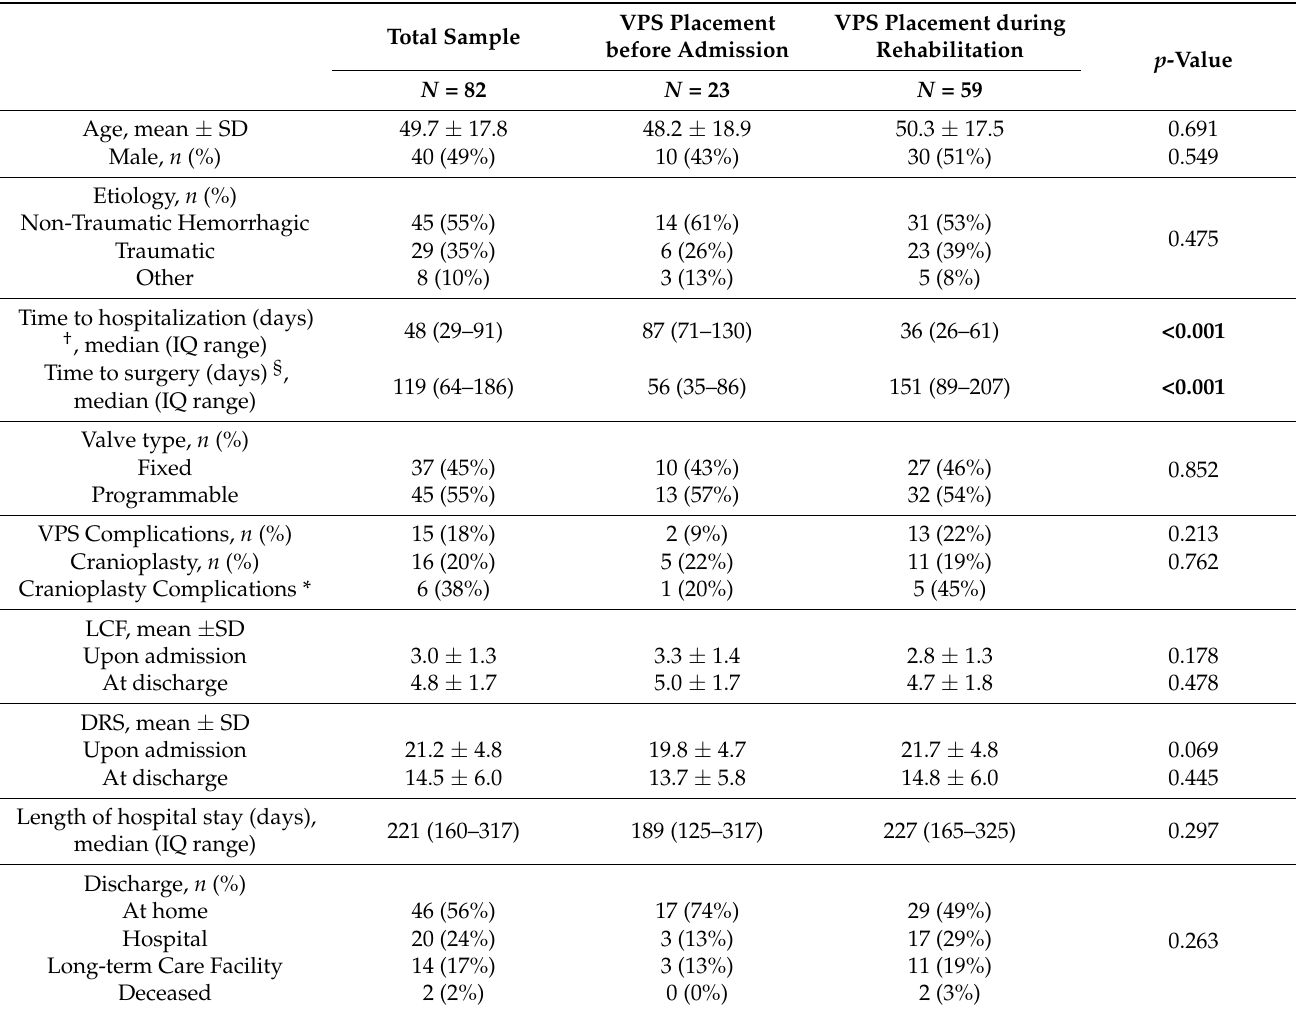
Table 1. Characteristics of the study